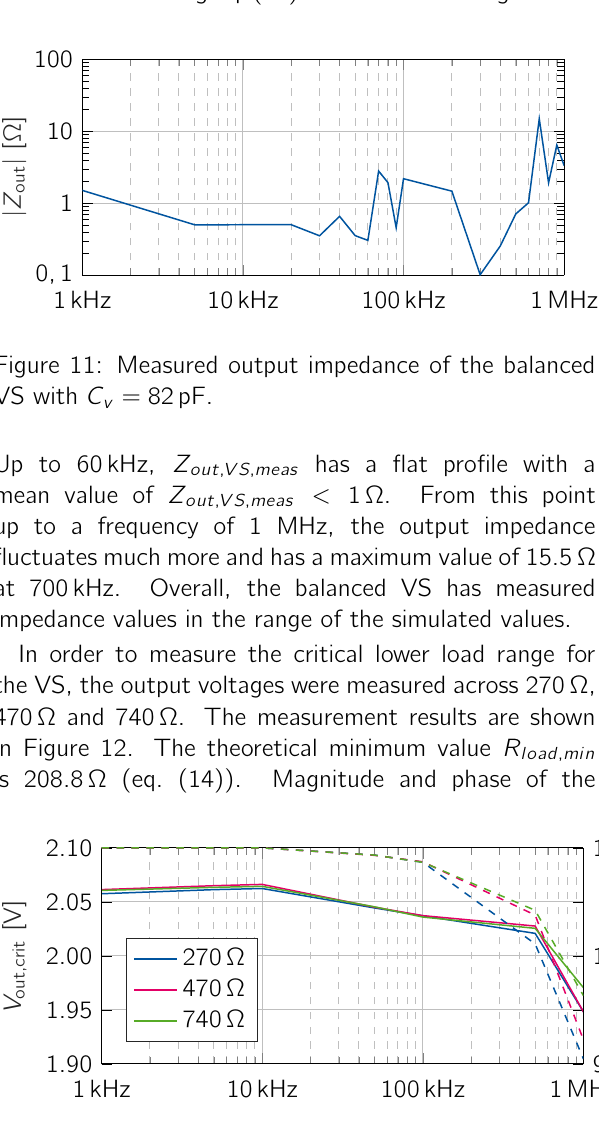
Figure 12: The output voltage (RMS value, solid line) of the VS were measured for loads in the critical lower load 740 (cid:10) . The phase is depicted as range. R load = 270 − dashed